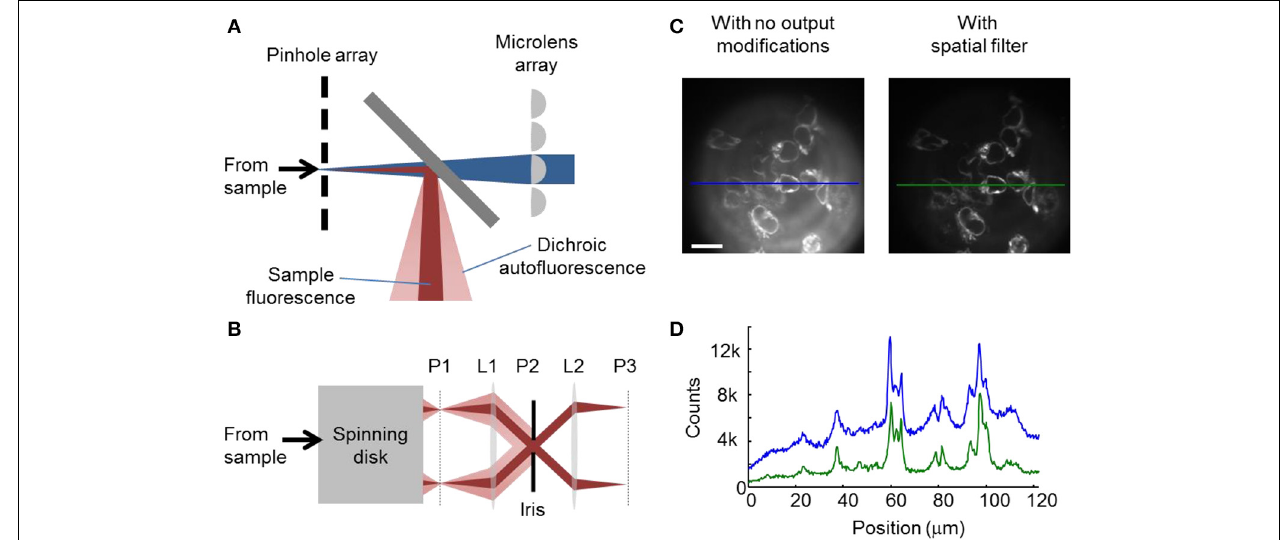
FIGURE 1 | Modified spinning disk confocal microscope for high-sensitivity imaging. (A) Internal optics of the spinning disk unit. The pinhole array and the microlens array are mounted co-axially on a shaft that rotates both at a high speed (typically 10,000rpm). The excitation light ( blue ) passes through the short-pass dichroic, from which it elicits undesirable autofluorescence (pink ). Fluorescence returning from the sample ( red ) emerges with a narrower cone-angle than autofluorescence of the dichroic.